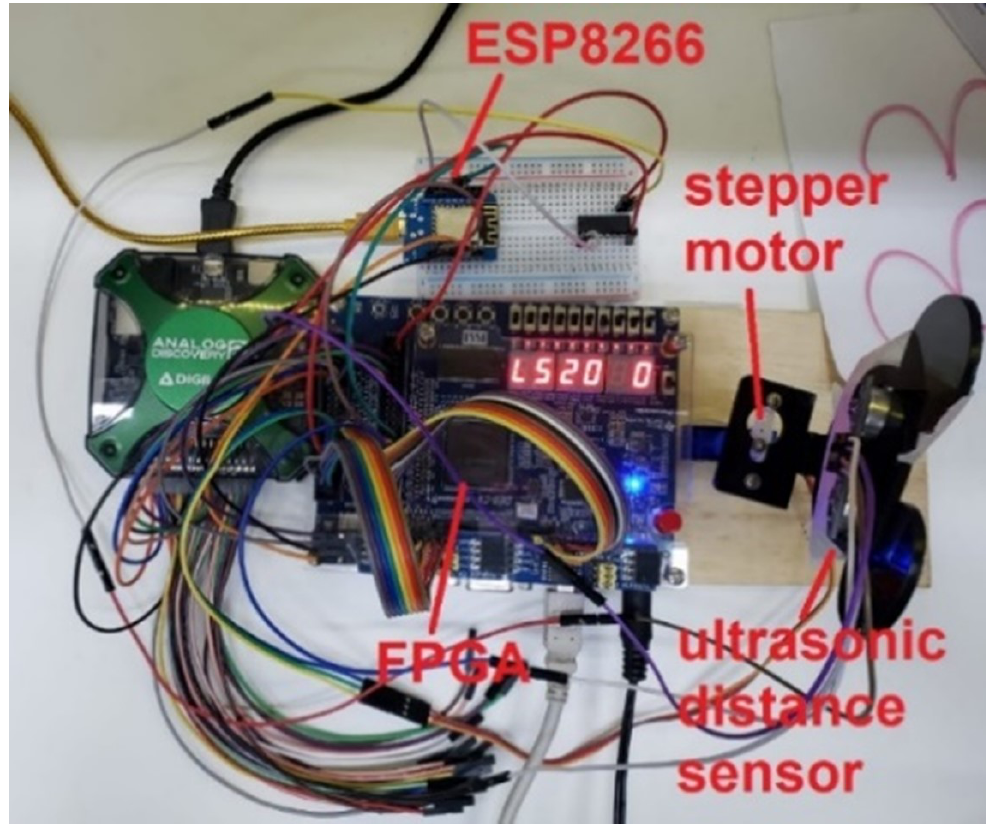
Figure 3. LabEAD physical